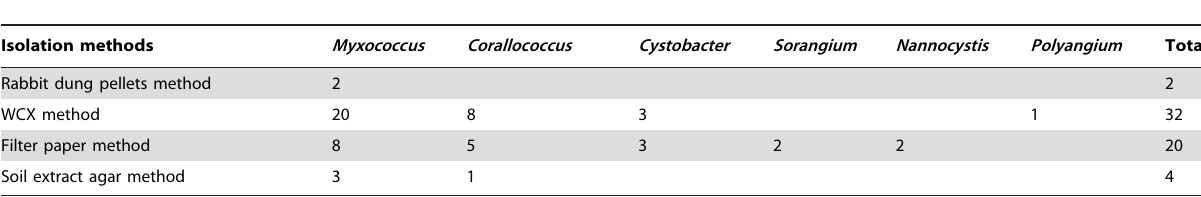
Table 2. Myxobacteria strains isolated by different methods.